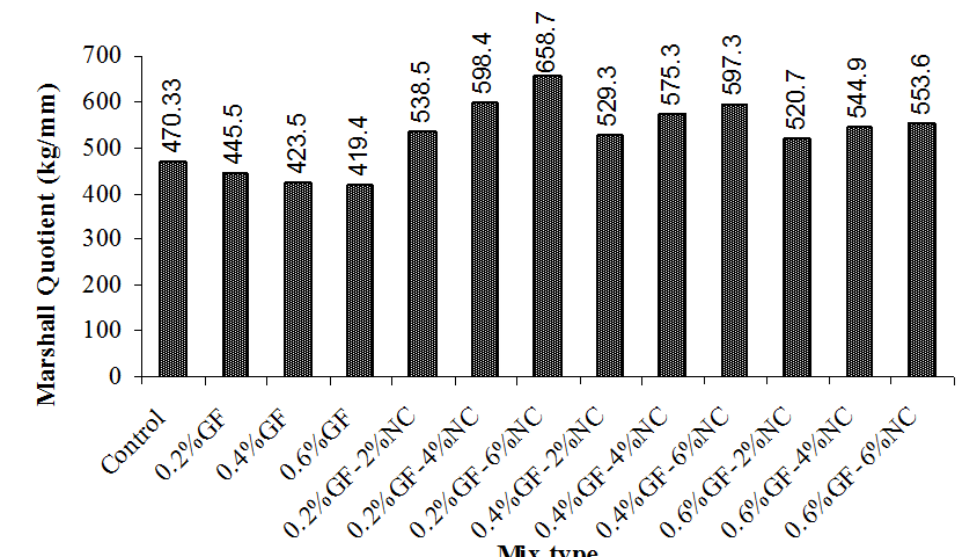
Fig. 3. Flow of mixtures